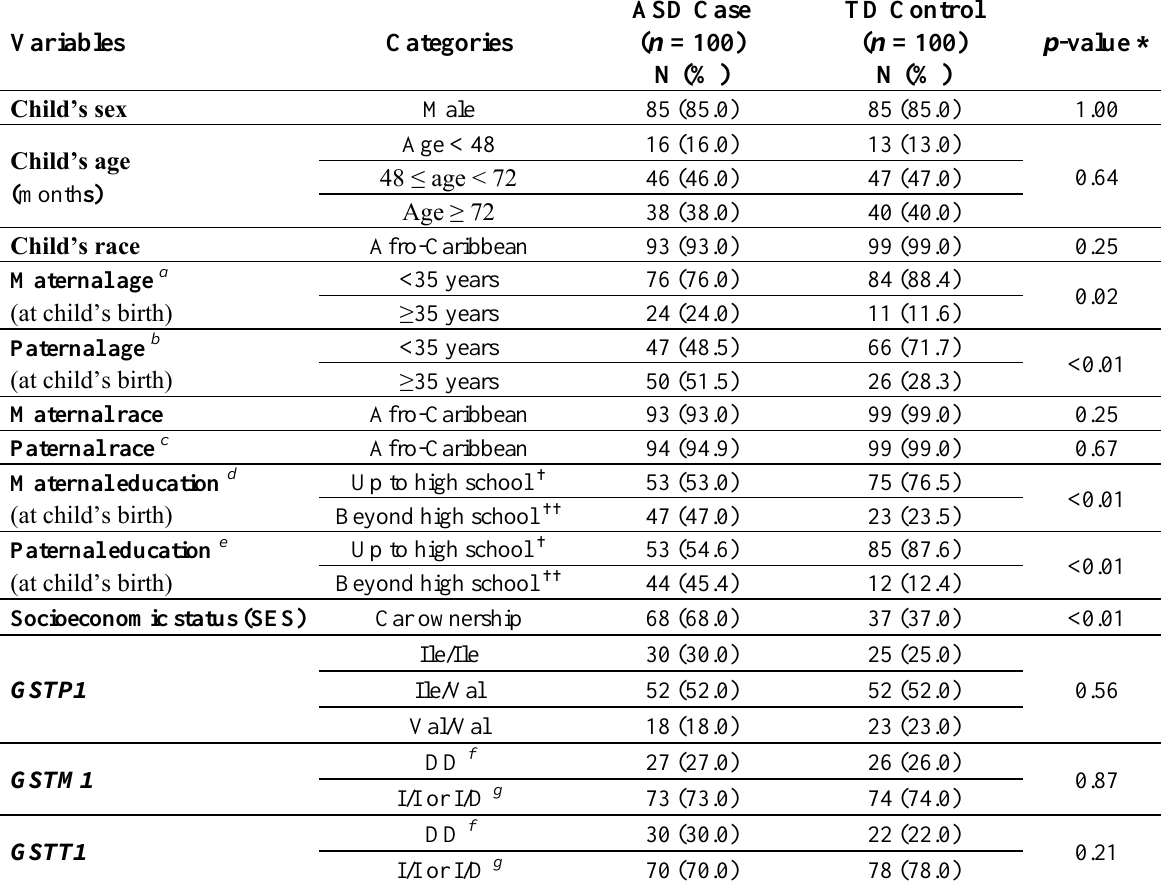
Table 1. Characteristics of children and their parents by autism spectrum disorder (ASD) case status (100 matched